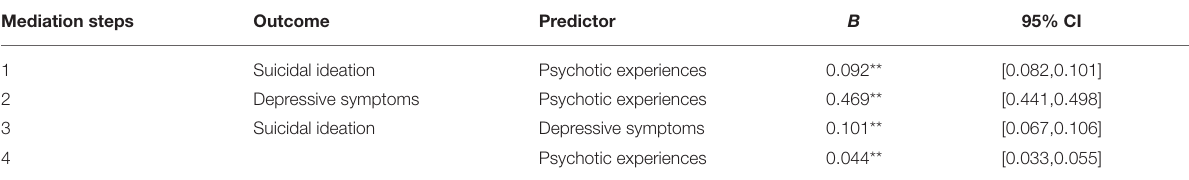
TABLE 6 | Mediation analysis of psychotic experiences, depressive symptoms, and suicidal ideation.